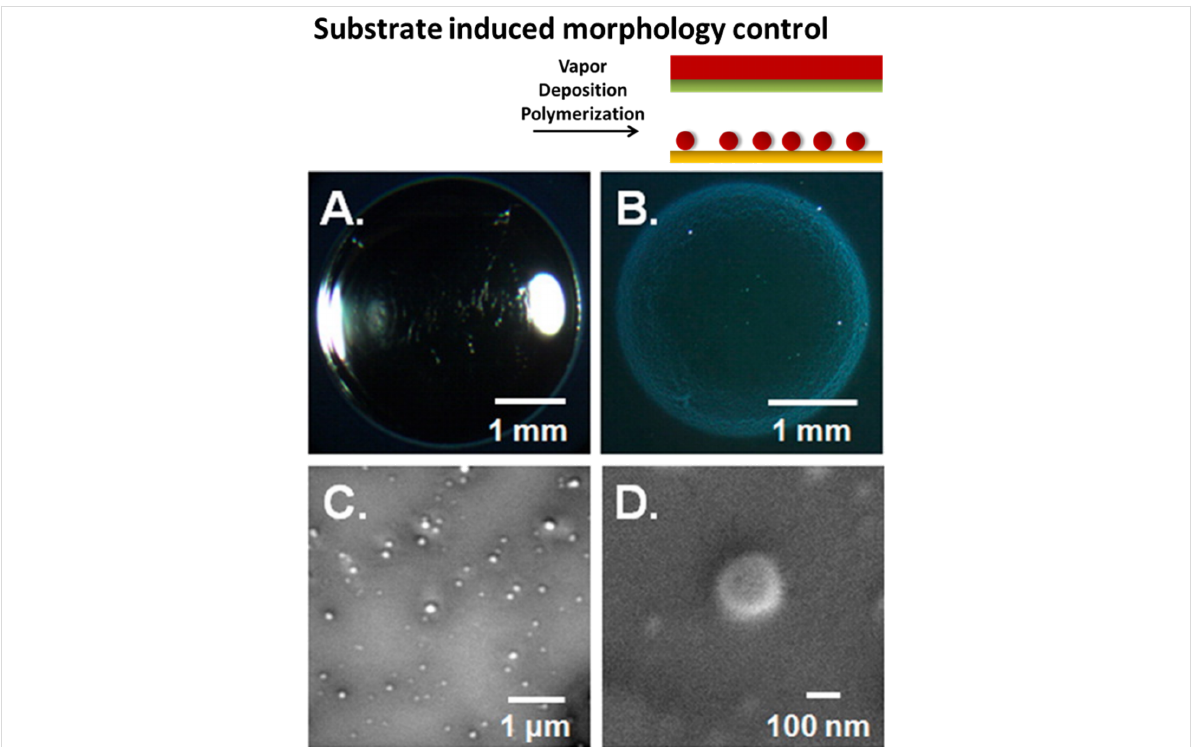
Figure 3: Variation of the polymer structure induced by the substrate: (A) polymer film formed when the spreading of the polymer on the liquid is ener- getically favorable, poly(1 H ,1 H ,2 H ,2 H -perfluorodecyl acrylate) on 1-ethyl-3-methylimidazolium tetrafluoroborate, (B) polymer particles formed under energetically unfavorable spreading conditions (poly(4-vinylpyridine) on silicone oil), and (C,D) scanning electron images of poly(4-vinylpyridine) polymer particles. Reprinted with permission from [29], copyright 2013 American Chemical